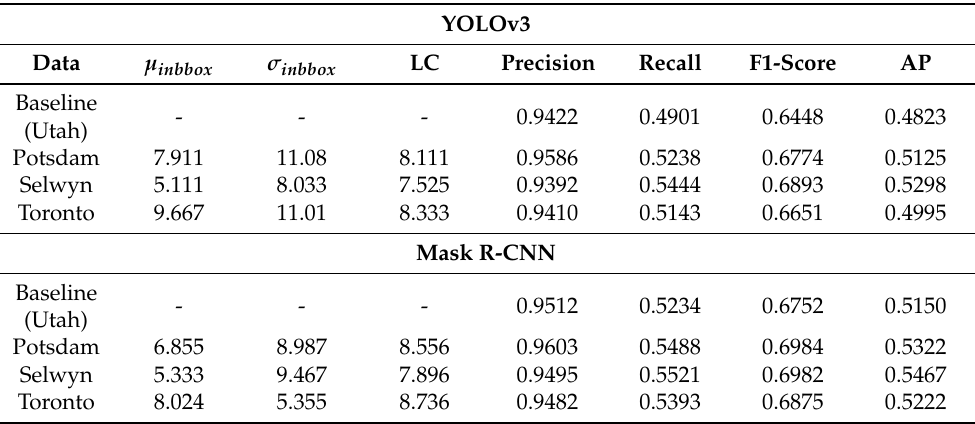
Table 5. µ inbbox , σ inbbox , Least-confidence score, Precision, Recall, F1-score, and AP of each model on the four-city dataset. µ inbbox , σ inbbox , and Least-confidence score were calculated on each unknown city dataset BEFORE